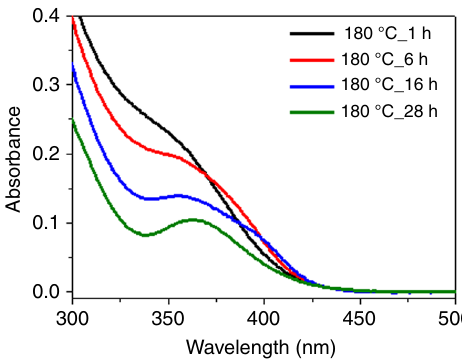
Fig. 7 Synthesis of F360-InP:Zn MSCs. UV − vis absorption spectra of aliquots taken during direct synthesis of F360-InP:Zn MSCs from In(Ac) 3 , ODPA, (TMS) 3 P, and Zn(SA) 2 precursors at